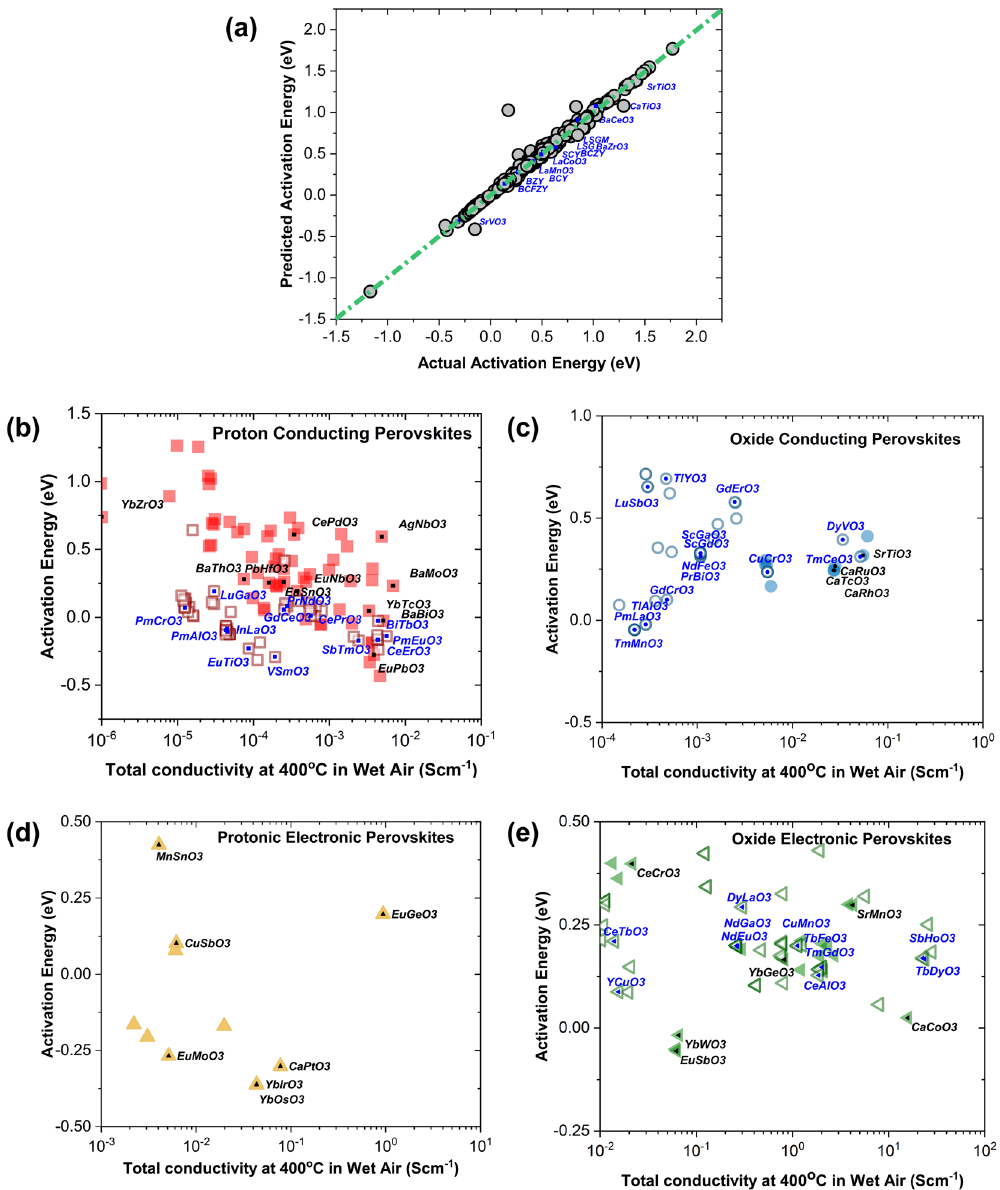
Fig. 5 Prediction of stable perovskites of different charge carrier types. a Comparison of the predicted activation energies with the experimental values. The RMSE for the prediction is 0.047 eV; screening of stable perovskites with energy above hull <0.05 eV and 0.7 < tolerance factor < 1.1. (type I: darker symbols with black labels for highest conductivities at 400 °C for a given B-site and type II: lighter with dark blue labels for highest conductivities at 400 °C for a given B-site), b proton-conducting, c oxide-conducting, d protonic/electronic, and e mixed oxide/electronic perovskites based on conductivities and activation energies. The predictions are made in wet